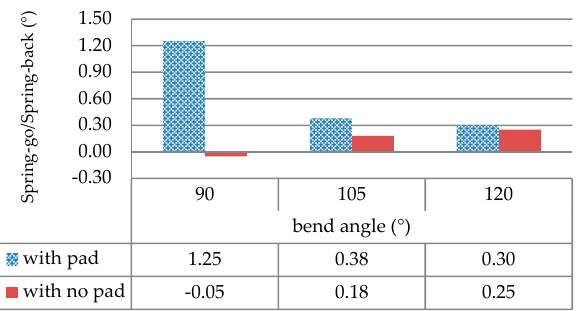
Figure 9. Comparison of the predicted spring-back/spring-go characteristics between the cases of U-bending, with and without pressure pads, with respect to bend angles ( R p : 7 mm, W : 30 mm, t : 3 mm, WP L : 120 mm, R ud : 5 mm).